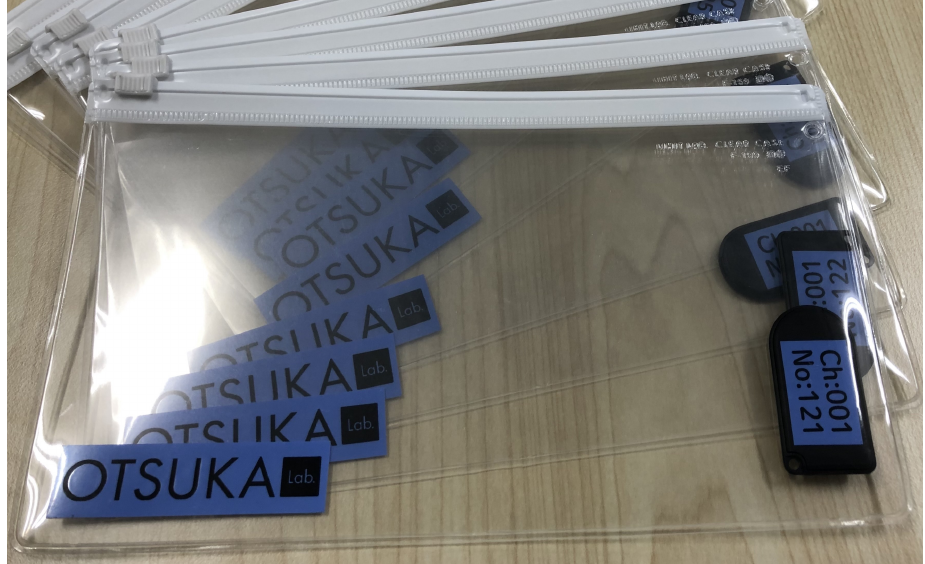
Figure 2. Test Kanbans and BLE